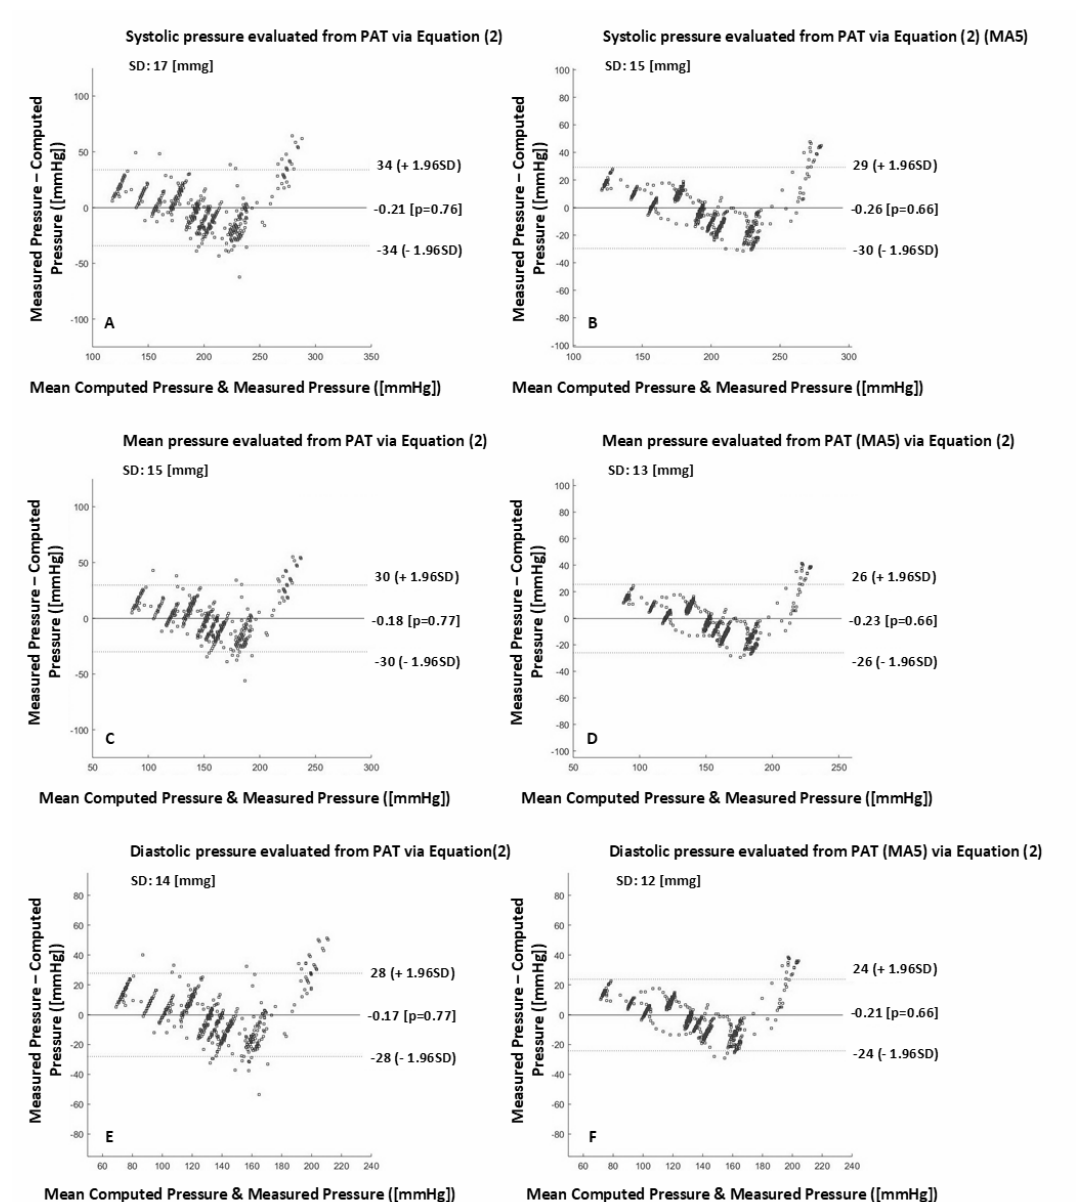
Figure 8. Bland Altman comparisons of BPs measured experimentally vs. those computed via model proposed by Magder S. [28] (Equation (6)). Comparisons of SBP is shown ( A , B ), MAP ( C , D ) and DBP ( E , F ) for non-averaged values ( A , C , E ) and averaged values over five cycles ( B , D , F ).Averaging was made thanks to moving average method (MA5). In all cases, there is no systematic deviation between measured and computed BPs, while the standard deviation decreases when the response is averaged over more